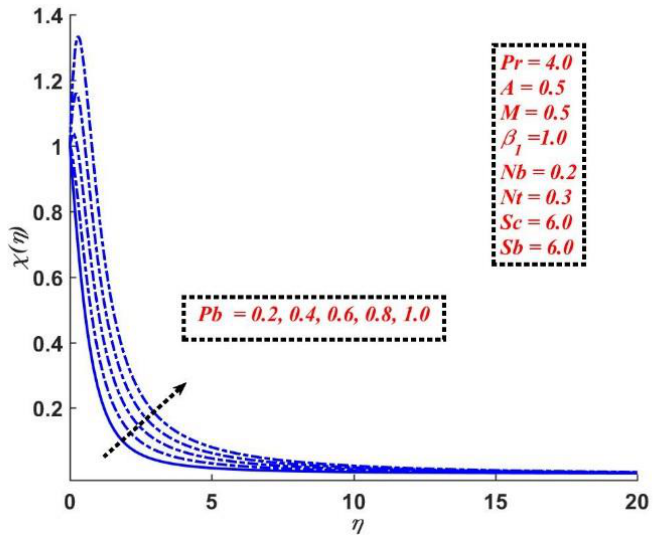
Figure 13. Influence of the bio-convective Peclet number on 𝜒(𝜂) .